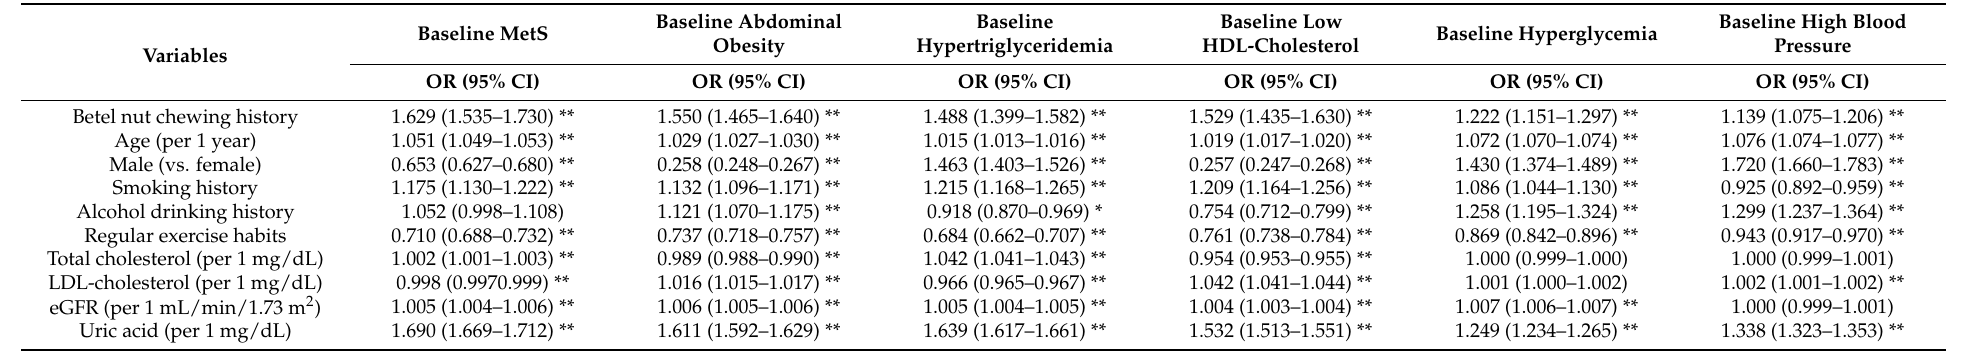
Table 2. Association of betel nut chewing history with baseline MetS and its components in all study participants ( n = 121,423) using multivariable logistic regression analysis.